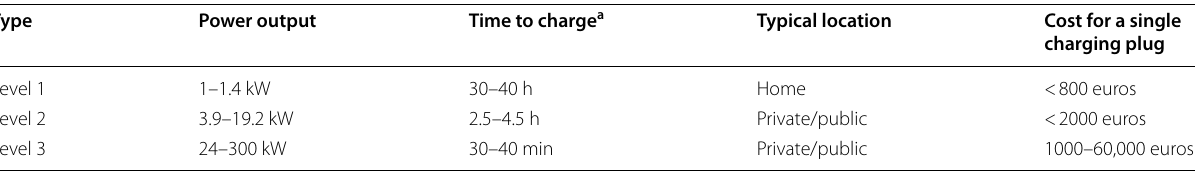
a Based on the charging time of a 60-kWh battery from 10 to 80%